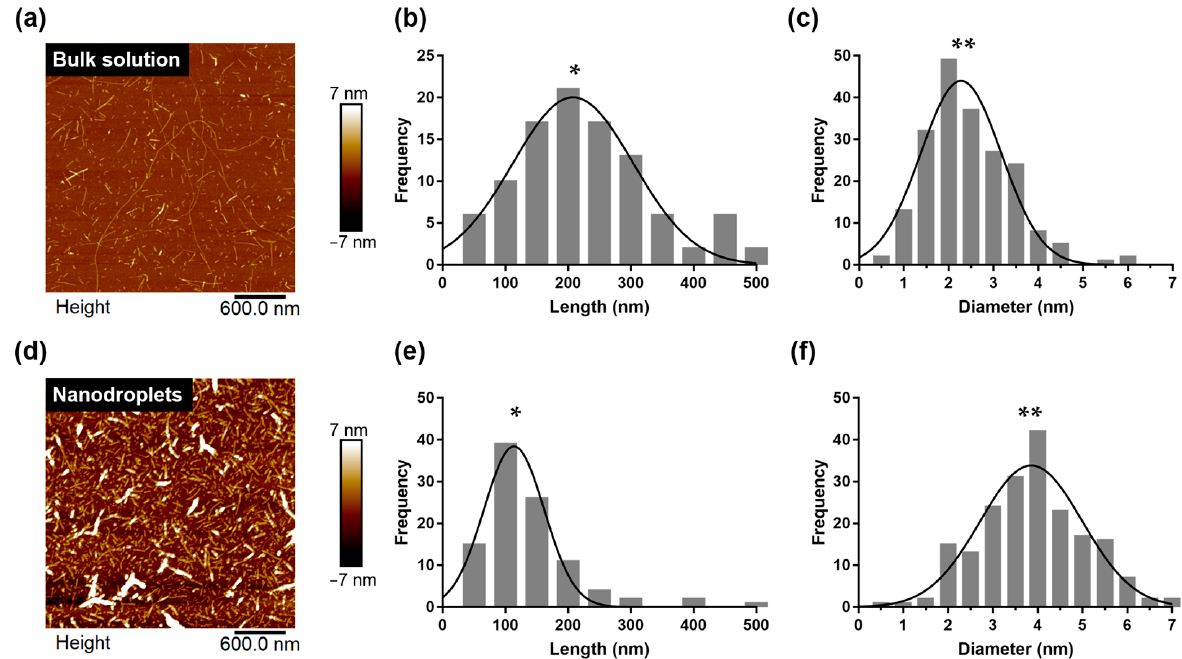
Figure 5. Comparison of structural information of HEWL amyloid fibrils formed in bulk solution and nanoliter droplets. ( a ) AFM image of HEWL amyloid fibrils formed in bulk solution. ( b ) Histo- grams of contour length. ( c ) Diameter distribution of HEWL fibrils from AFM image ( a ). ( d ) AFM image of HEWL amyloid fibrils formed in nanoliter droplets. ( e ) Histograms of contour length. ( f ) Diameter distribution of HEWL fibrils from AFM image ( d ) (* p -value < 0.0001; ** p -value < 0.0001).